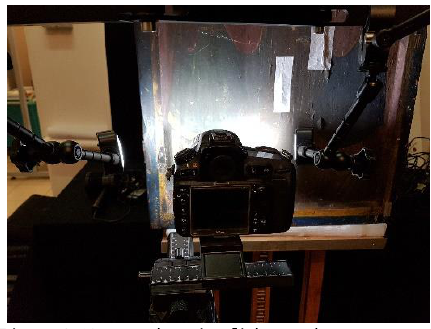
Figure 2. Macro shooting lights and camera setup